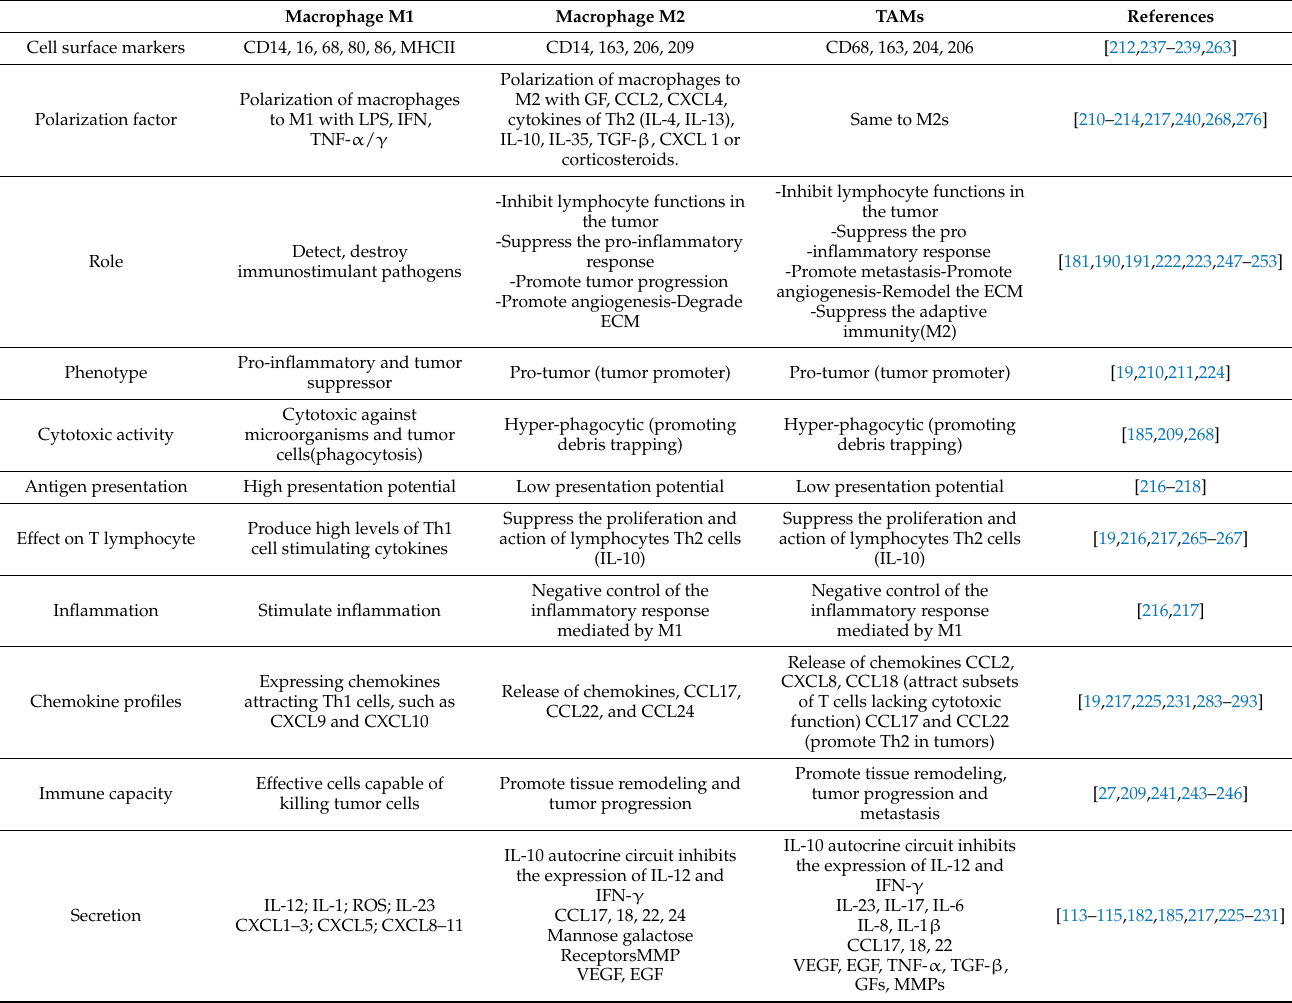
Table 1. Comparison between macrophages M1, M2, and